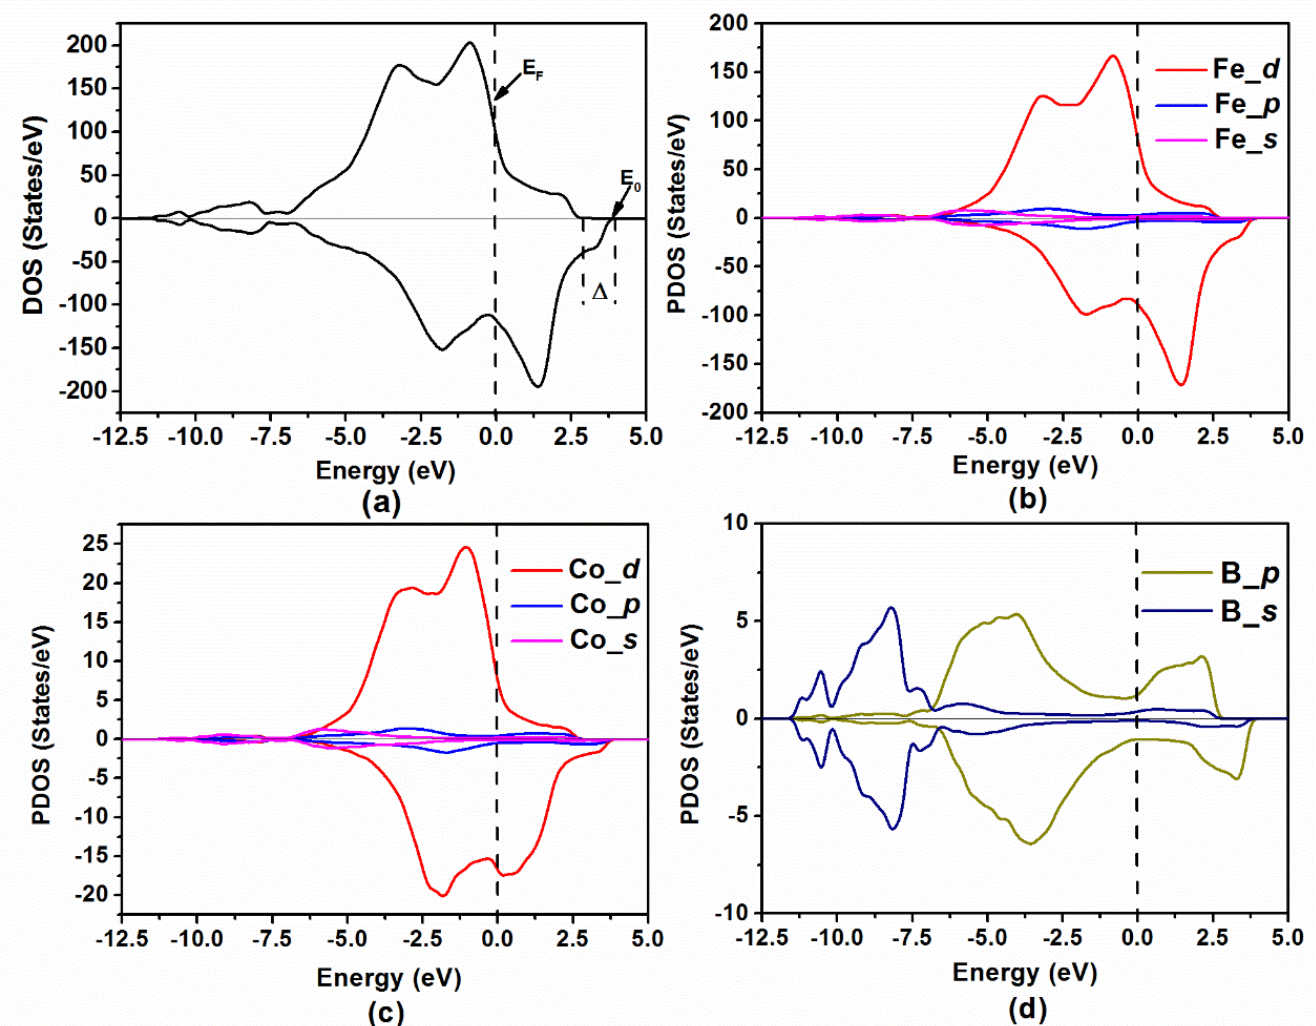
Figure 4. ( a ) Total density of states (DOS) of Fe 70 Co 10 B 20 amorphous alloy, where Δ is exchange splitting energy, E F is Fermi level, and E 0 is the top of the energy band. ( b – d ) partial density of states (PDOS) of Fe 70 Co 10 B 20 amorphous alloy for Fe, Co, and B, respectively.